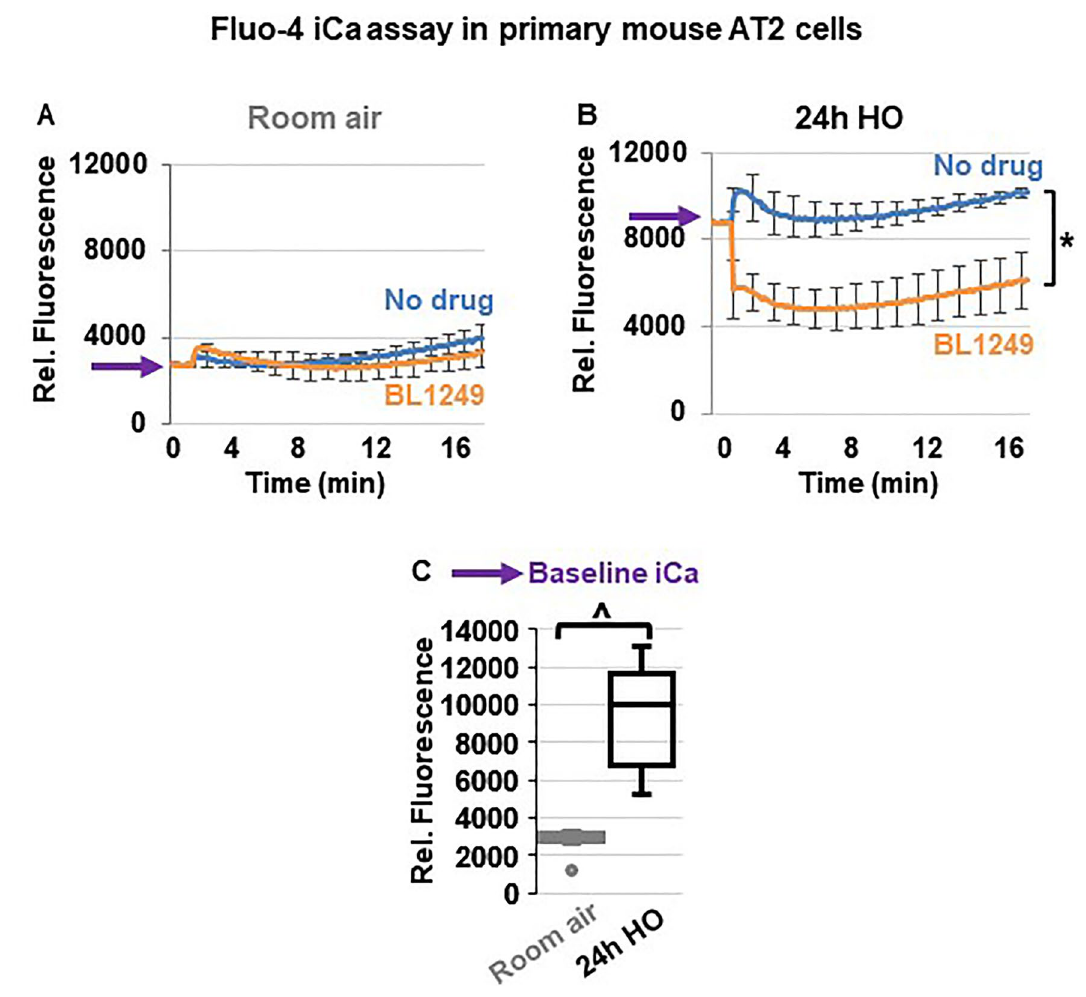
Figure 7. TREK-1 activation decreases intracellular Ca 2+ (iCa) concentrations in HO-exposed primary mouse AT2 cells: ( A , B ) Representative curves of Ca 2+ -sensitive Fluo-4 assays showing that HO-exposed AT2 cells contain higher iCa concentrations than RA-exposed cells, as indicated by an increase in fluorescence values (purple arrows on Y-axes). TREK-1 activation with BL1249 has no effect on iCa concentrations in RA-exposed cells, but decreases iCa levels in HO-exposed cells (*BL1249 compared to no drug/vehicle control, p ≤ 0.05). A summary of n = 6 independent experiments is shown in C ; data are represented as Box-Whisker plots